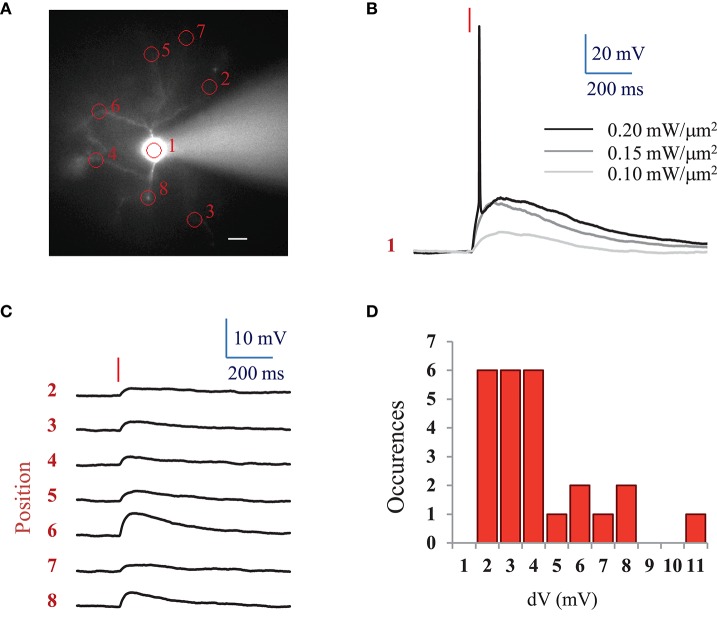
AP threshold with standard femtosecond Ti:Sapphire oscillator and spatial specificity of 2P holographic stimulation of ReaChR. (A) Widefield fluorescence image of L2/3 ReaChR-expressing neuron filled with 20 μM Alexa 594. Scale bar: 15 μm. (B) Voltage response (single recording) to a 10 ms long (red line) 2P holographic stimulation with a standard femtosecond Ti:Sapphire oscillator at 950 nm using a circular spot on the cell soma (1 in panel A, 15 μm diameter) for increasing LPDs. (C) Average voltage response (n = 3 repetitions) to a 10 ms long (red line) 2P holographic stimulation with a standard femtosecond Ti:Sapphire oscillator at 950 nm on numbered circular spots (15 μm diameter) in panel A. LPD: 0.2 mW/μm2. (D) Distribution of average voltage response (n = 3 repetitions, 25 spots, 3 cells) to a 10 ms long (red line) 2P holographic stimulation with a standard femtosecond Ti:Sapphire oscillator at 950 nm on cell processes. Distance from the soma from 15 to 100 μm, as shown in panel A. LPD corresponding to the one used to reach the AP threshold for 2P stimulation on the cell soma for each cell (0.15 to 0.25 mW/μm2).